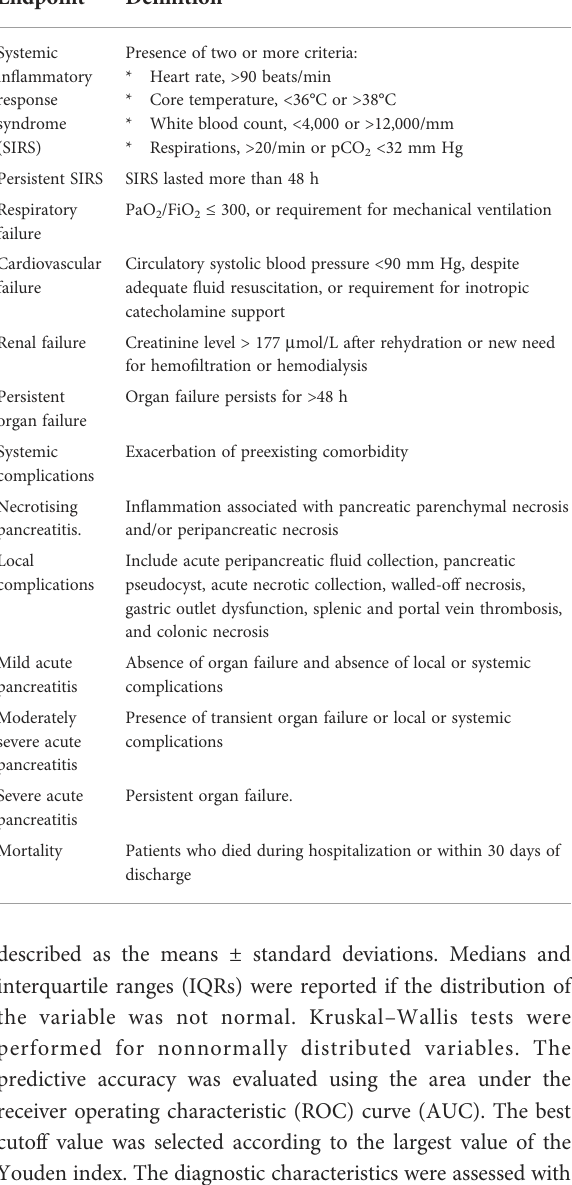
TABLE 1 De fi nitions of